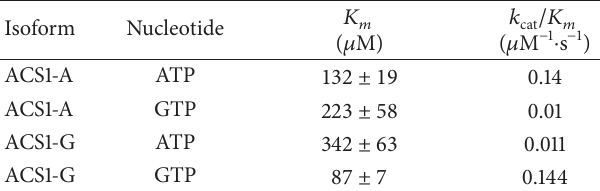
Table 2: Nucleotide kinetics of ACS1 isoforms.